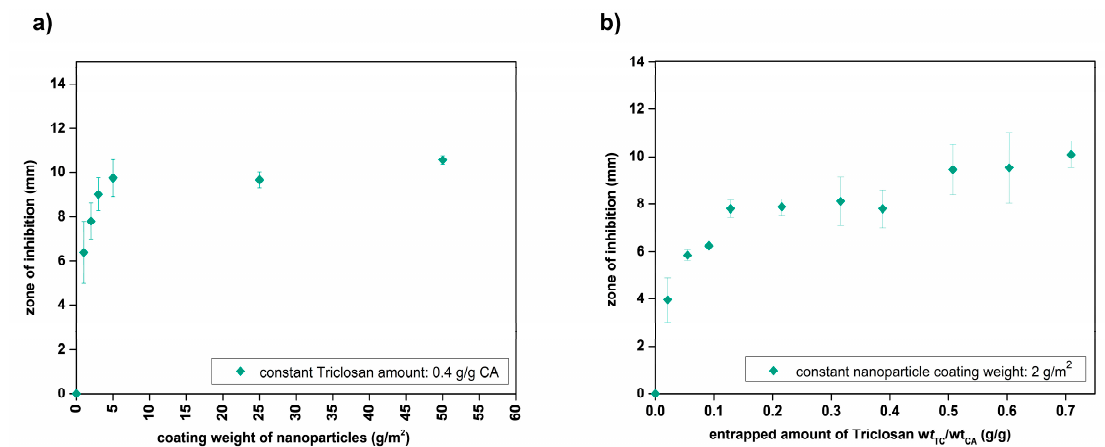
Figure 10. Zone of inhibition of Triclosan-loaded nanoparticles with variation of biocide loading concentration ( a ) and particle coating amount ( b ).